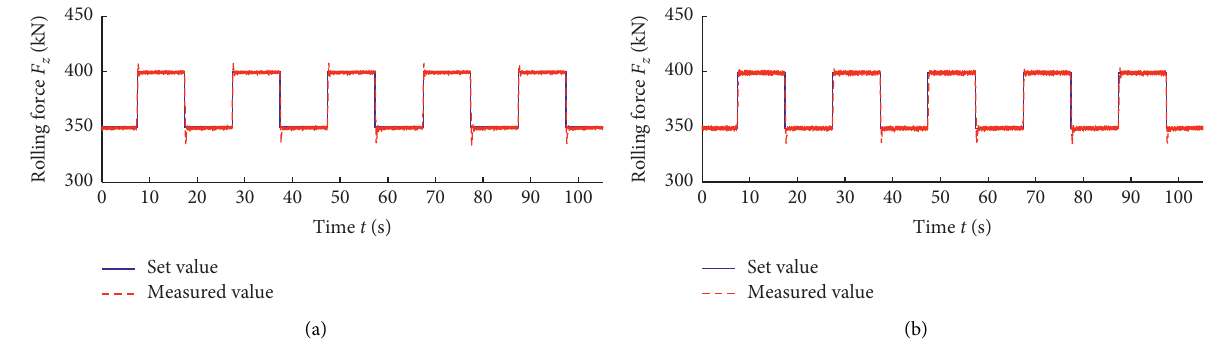
Figure 12: Following effect of rolling force when a square wave signal is input. (a) Operation side. (b) Drive side.